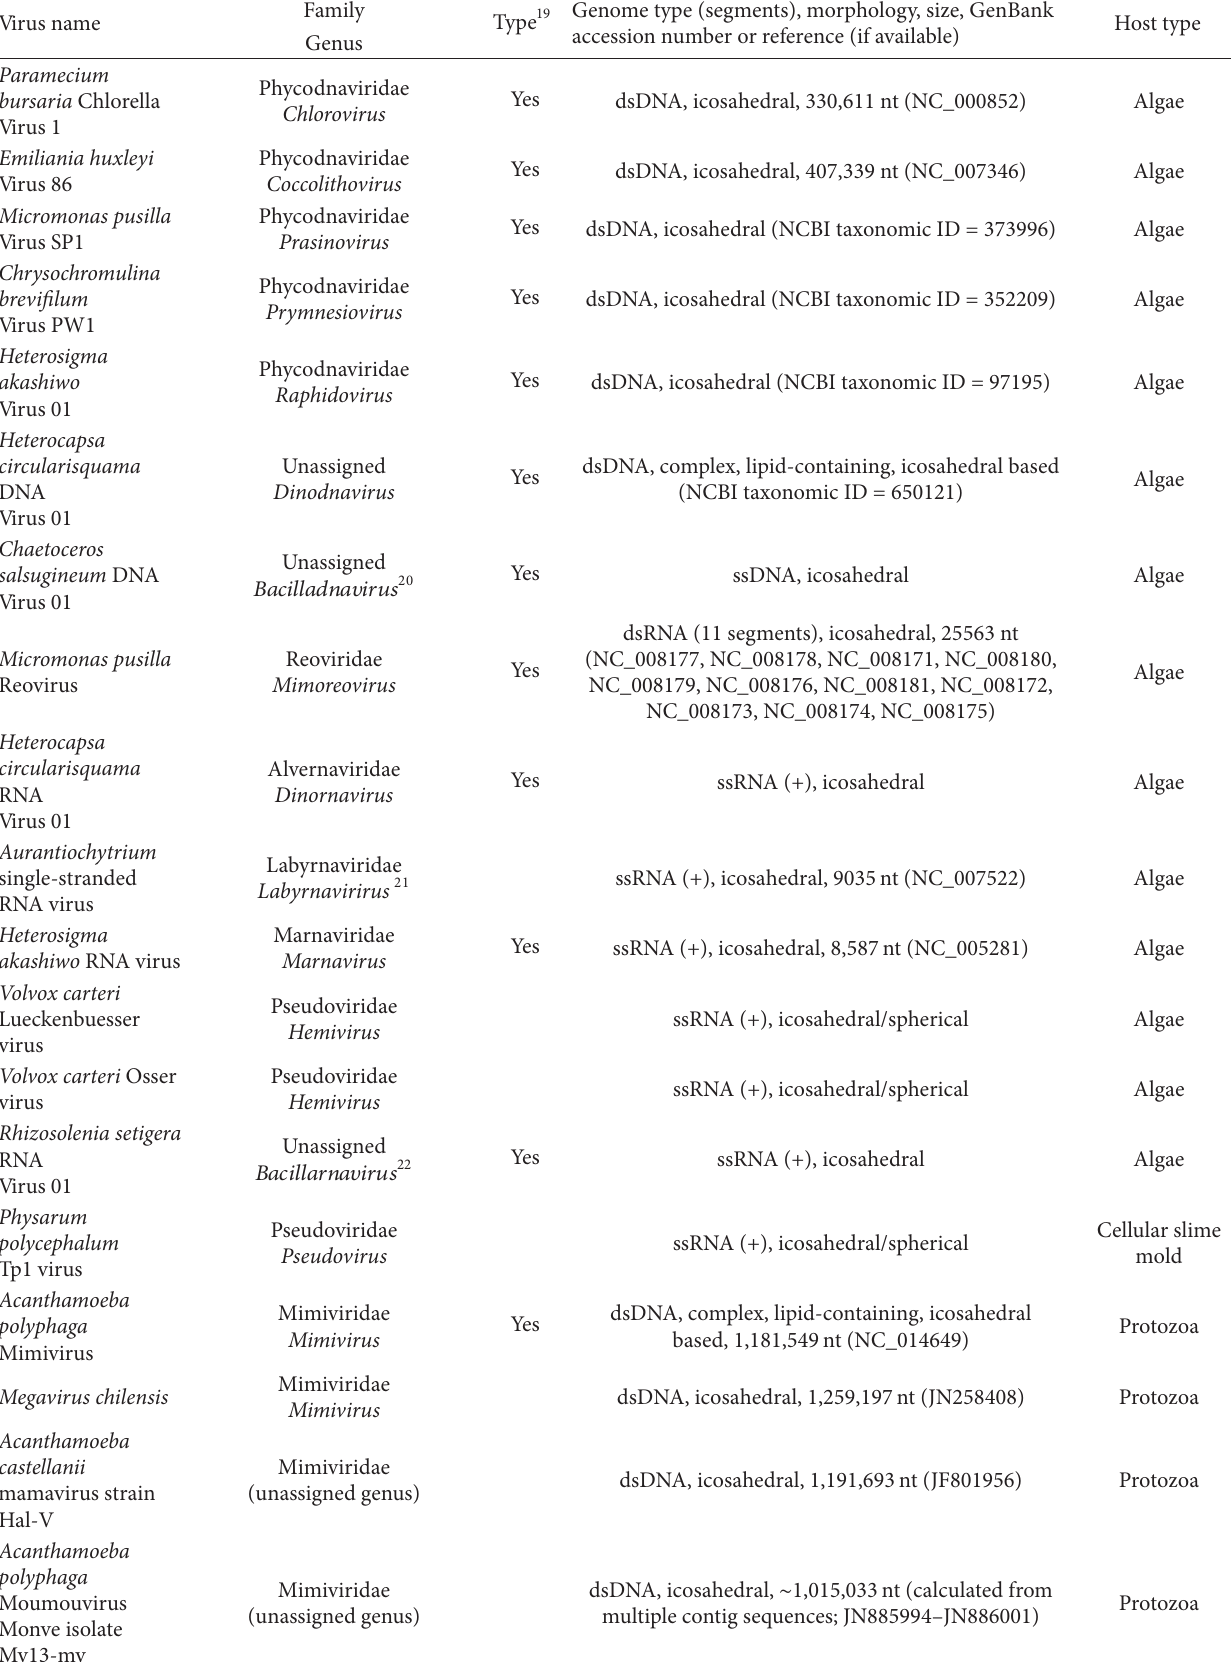
T 3: Notable viruses of